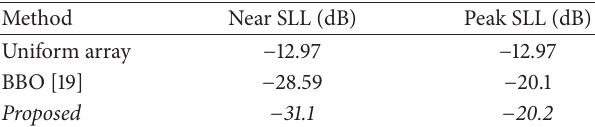
Table 13: Peak SLL and null depths for Example 7 .